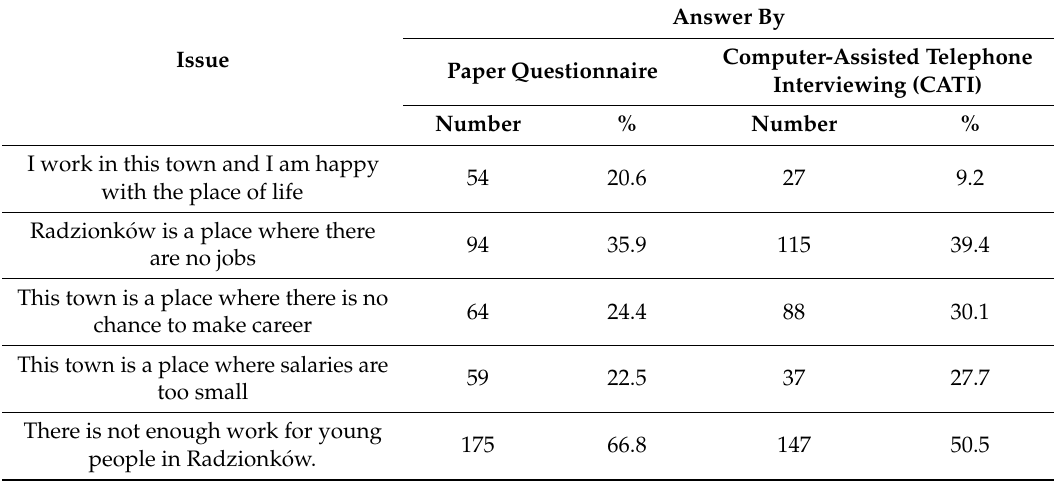
Table 3. Survey of Radzionk ó w residents regarding the realities of life in 2013. Selected issues. Answer By Computer-Assisted Telephone Issue Paper Questionnaire Interviewing (CATI) Number % Number %